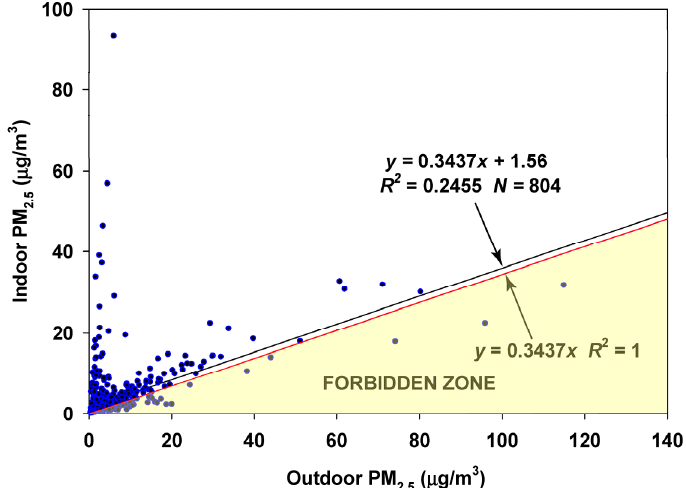
Figure 3. Random Component Superposition (RCS) regression for Oakmont.